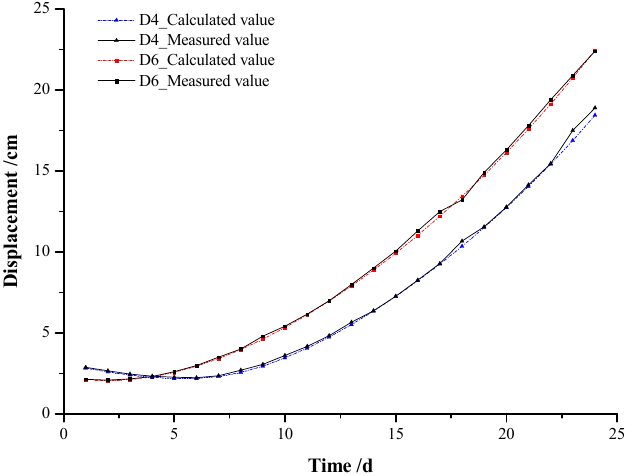
Figure 13. Variation of perimeter displacement with elastic modulus of primary support. From Figures 14–16, we note that the displacements of monitoring points No. 1 (Node 8), No. 2 (Node 69), No. 3 (Node 13), No. 4 (Node 70), No. 5 (Node 17), and No. 6 (Node 20) on tunnel primary support structure present an approximate upward concave parabolic change with rheological time. The displacements of the monitoring point No. 1 at the vault have the largest among them.